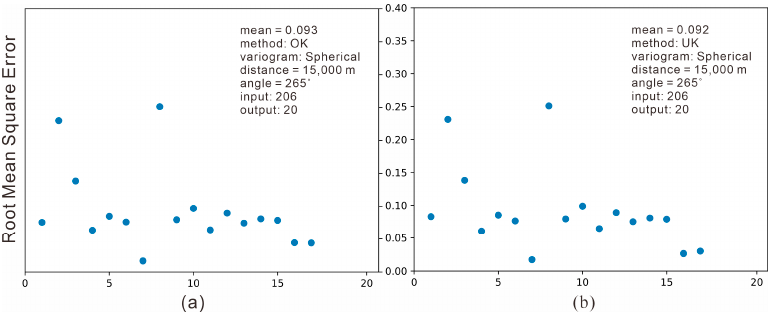
Figure A10. An additional test to compare the RMSE of different methods: ( a ) OK; and ( b ) UK. The mean RMSEs and parameters are listed in the top right-hand corner.